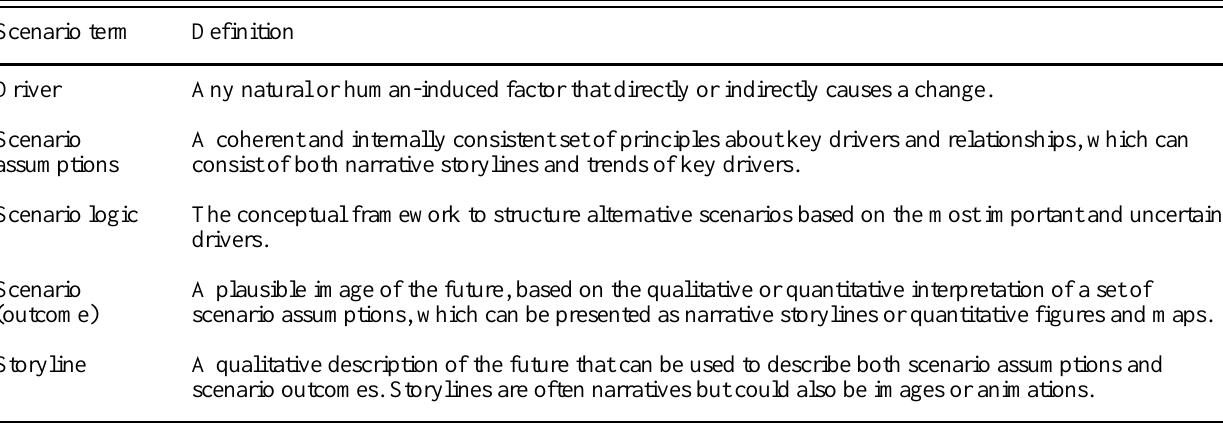
Table 2. Definitions of the most important scenario terminology used in this